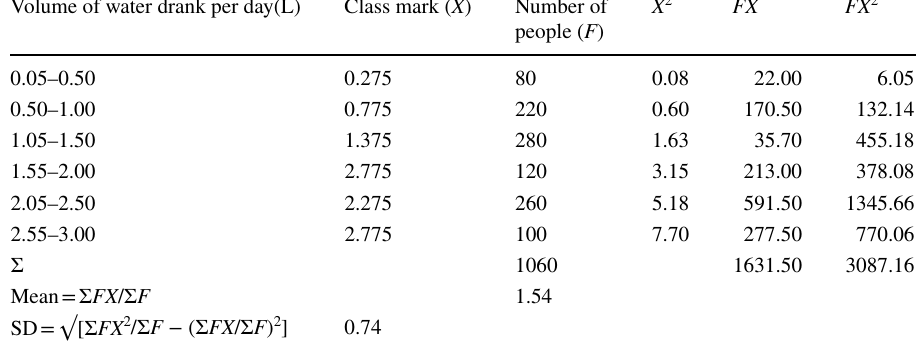
Table 6 Drinking water consumption per person/ day in Afikpo North